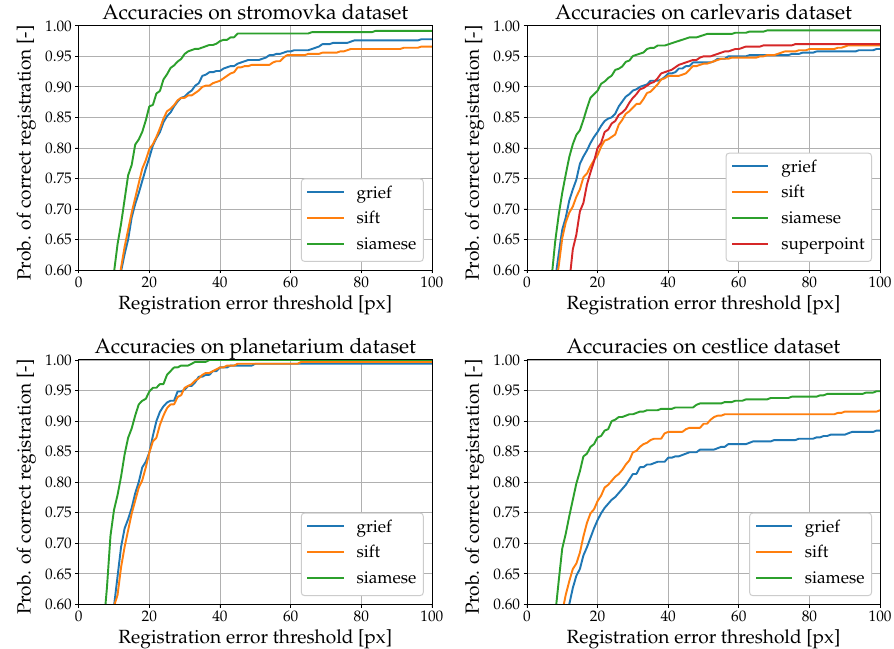
Figure 9. Cumulative distribution functions of the registration error achieved for the individual methods and datasets. Cumulative distribution was calculated as the ratio of samples where the method estimated the displacement in pixels to be under a certain threshold (shown on the x -axis). A detailed description of the cumulative distribution function calculation is provided in Section 4.4. For every dataset, Siamese networks outperformed other methods.